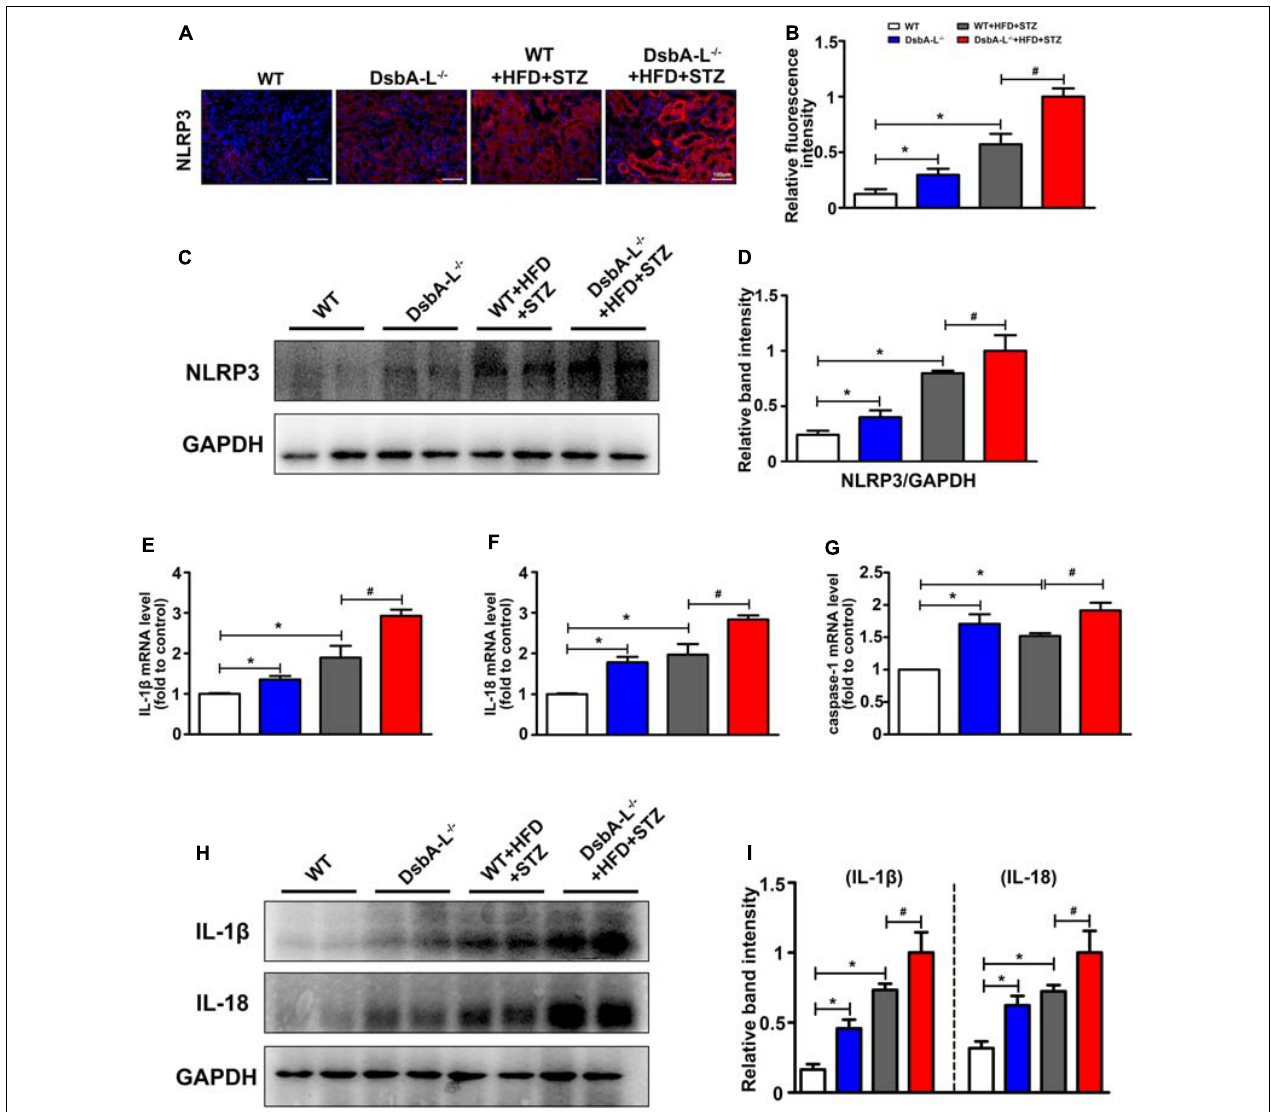
FIGURE 2 | Activated NLRP3 inflammasome in the kidneys of diabetic DsbA-L-deficient mice. (A,B) IHC staining reveals the increased expression of NLRP3 in the kidneys of diabetic DsbA-L − / − mice. (C,D) Western blot analysis further confirms the increased expression of NLRP3 in the kidneys of diabetic DsbA-L − / −